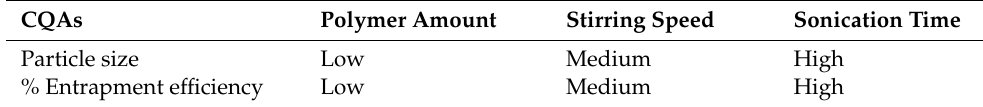
Table 6. Critical Quality Attributes (CQA) parameters.